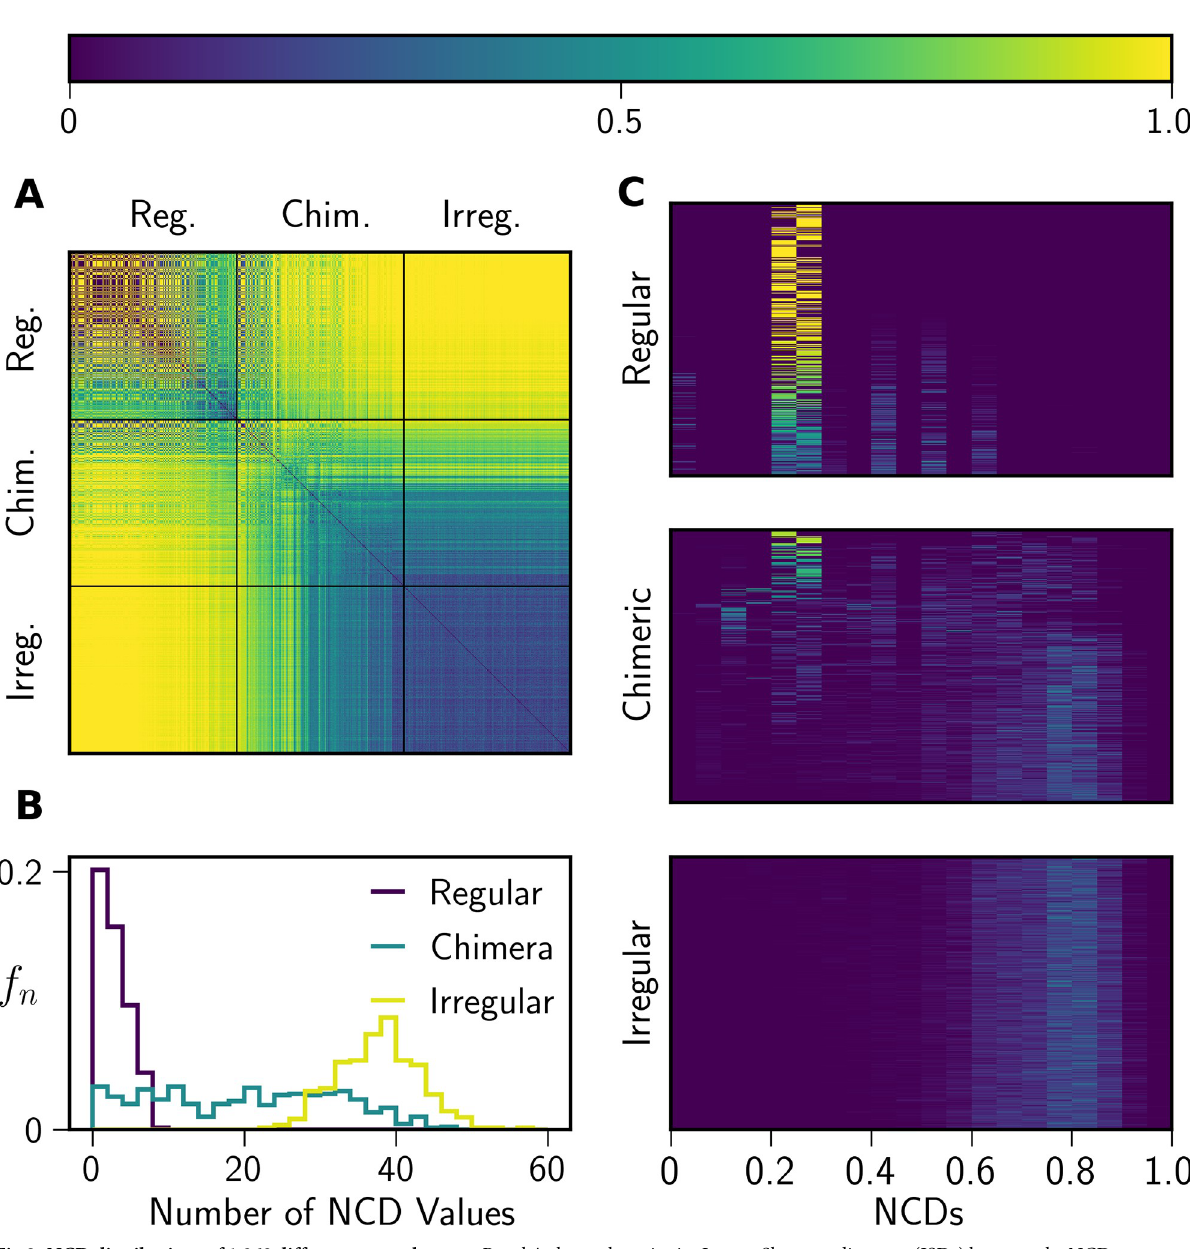
Fig 8. NCD distributions of 1,260 different network states. Panel A shows the pairwise Jensen-Shannon distances (JSDs) between the NCD distributions of 1,260 different network states. Thick black lines separate the three different classes of network behavior as determined by ISI statistics. The JSDs within each block are sorted by increasing NCD distribution entropy from left to right. For the chimera states, 30 network states with each number of synchronized nodes (2 to 15) are shown. Panel B shows the distribution of the number of NCD values for each network state in A , and panel C shows the distributions of NCD values that are compared pairwise in the Jensen-Shannon distance